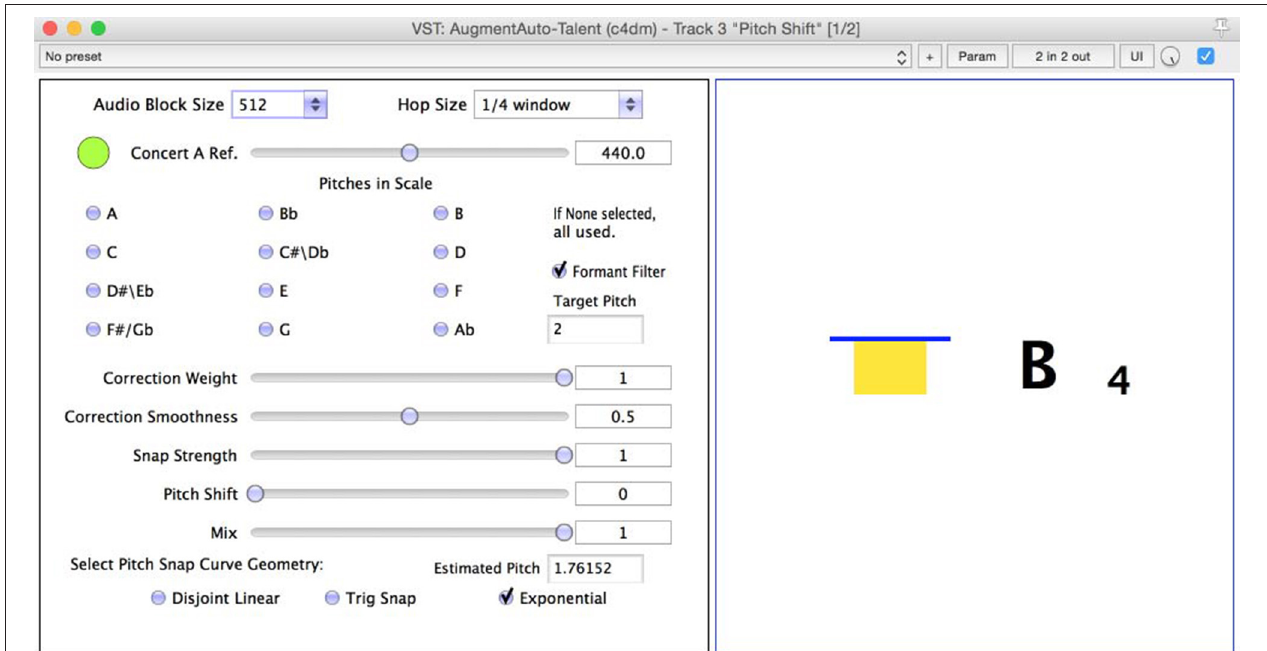
FIGURE 2 | Interface for the selection of pitch snap properties and notes included in the snapped scale (left) , along with a display of the performed pitch and the intonation relative to that pitch (right) .